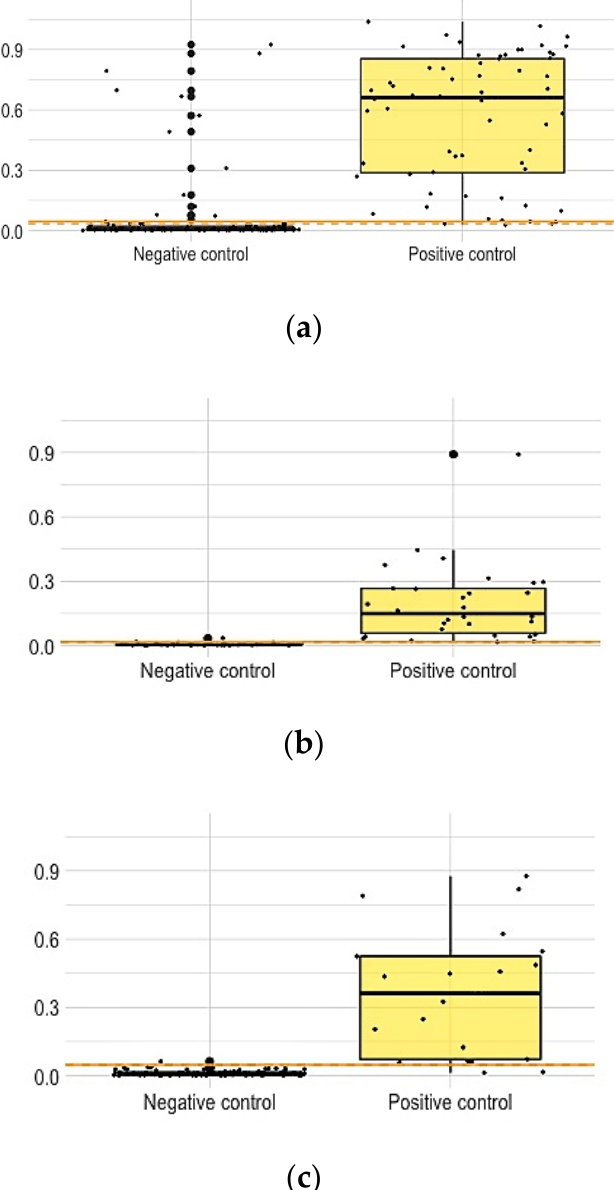
Figure 1. Distribution of the normalized MFI values for M. bovis ( a ), B. suis ( b ), and T. spiralis ( c ). Dots correspond to actual MFI values. Boxes represent interquartile ranges while the solid black line at the approximate center of each box is the median; the arms of each box extend to cover the central 95% of the distribution of the normalized MFI values.